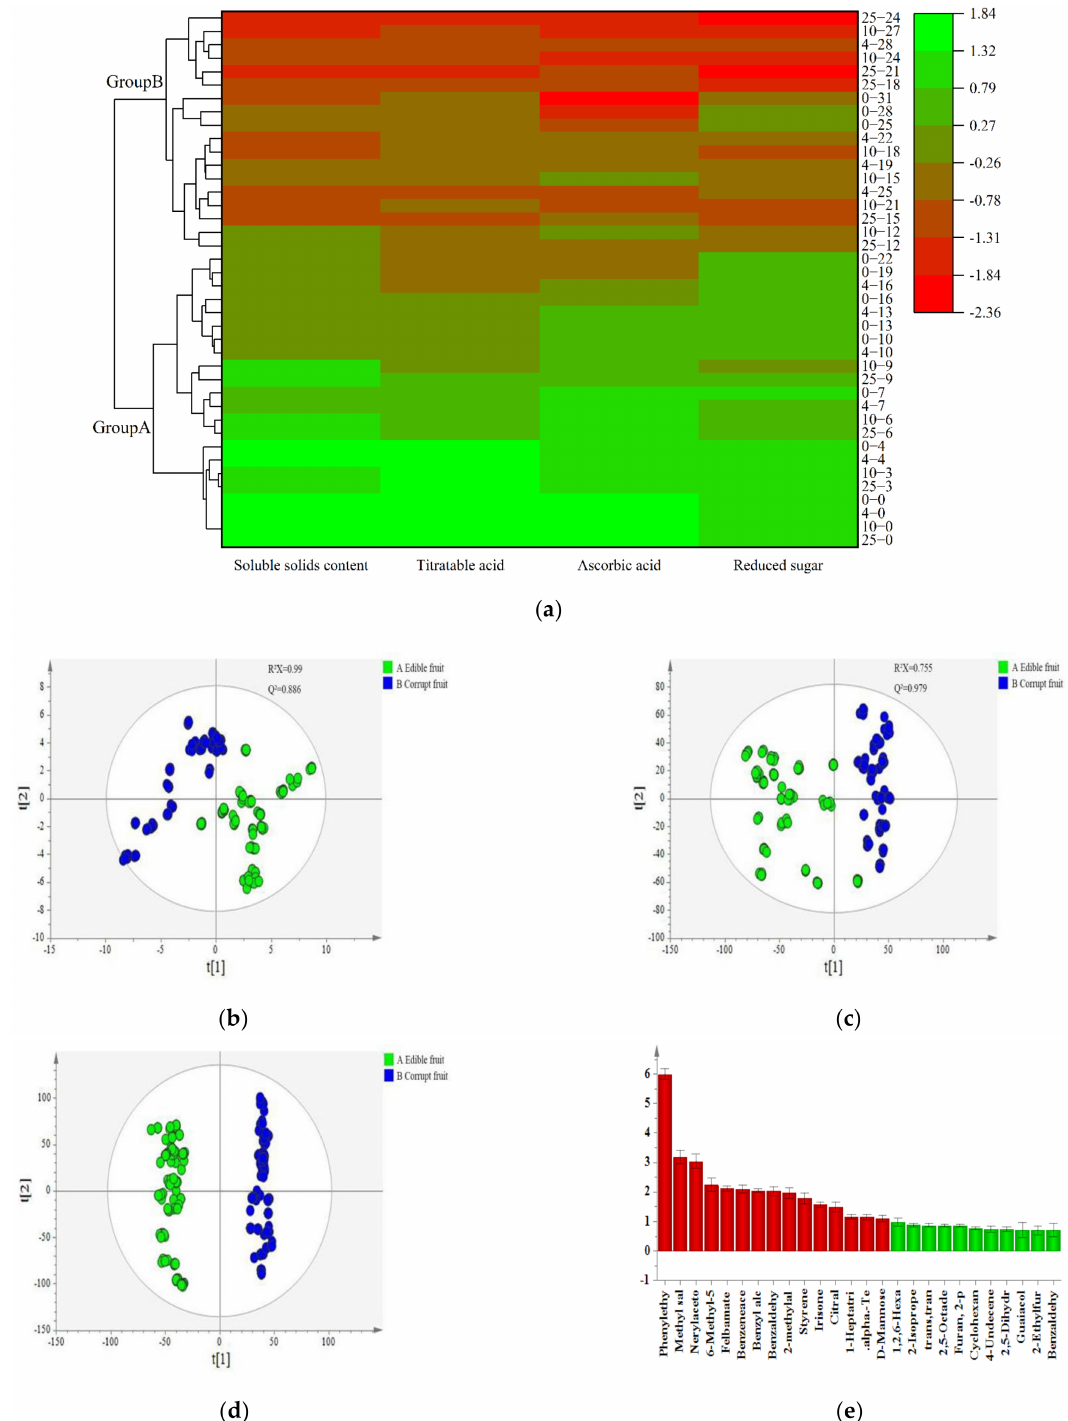
Figure 3. Cluster analysis heat diagram ( a ), PCA score plots based on GC–MS data ( b ), PLS-DA score plots based on GC–MS data ( c ), OPLS-DA score plots based on GC–MS data ( d ) and VIP plots based on GC–MS data ( e ) for cherry tomatoes edible and corrupt fruit. Note: Figure 3a, group A represents the edible fruit and group B represents the corrupt fruit. The first number represents the storage temperature and the number after the horizontal line represents storage time, e.g., 25–3 indicates cherry tomato samples stored at 25 ◦ C for 3